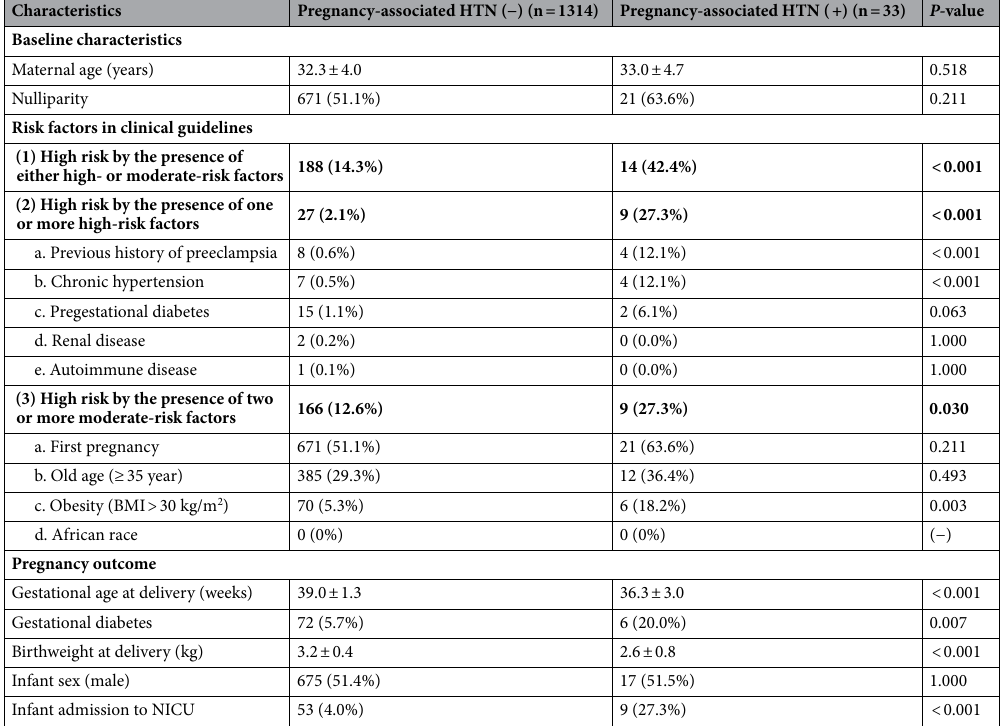
Table 1. Baseline clinical features and pregnancy outcomes of the study population. Data are presented as proportion (%) or mean standard ± deviation. BMI body mass index, HTN hypertension, NICU neonatal intensive care unit.